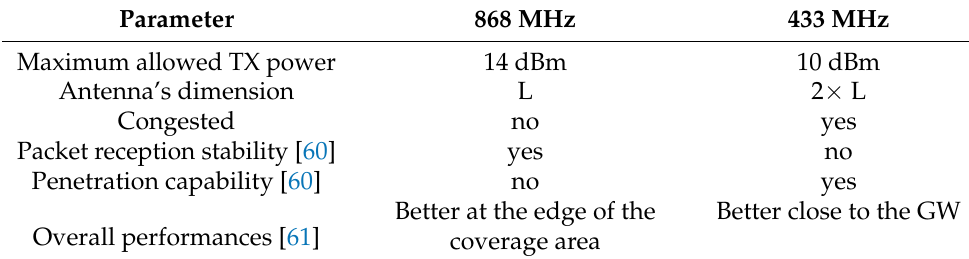
Table 2. Comparison between LoRa on 868 MHz and LoRa on 433